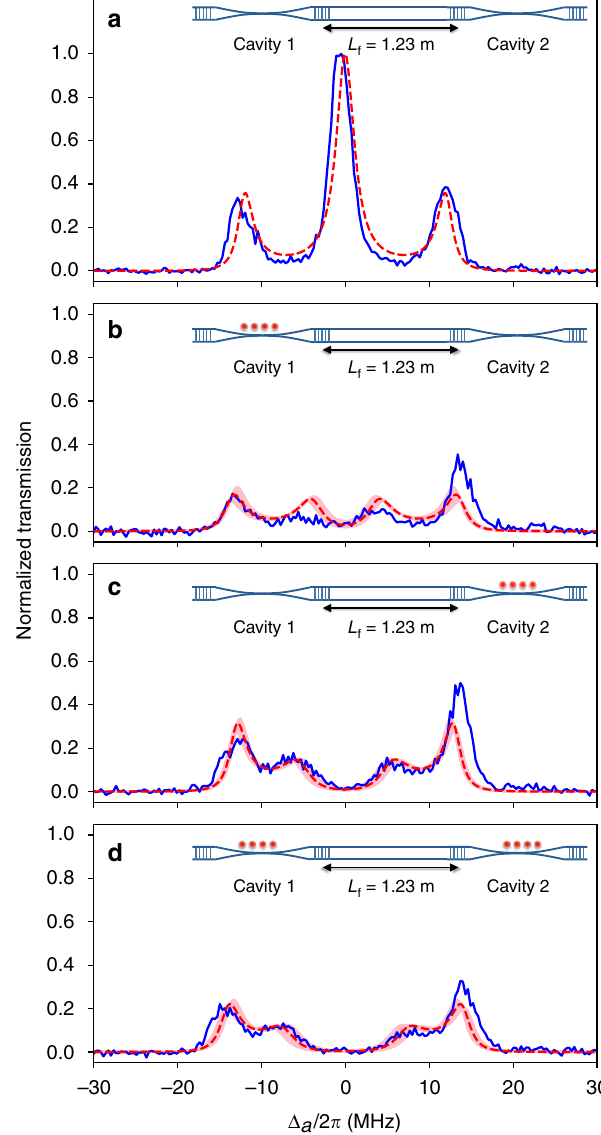
Fig. 2 Transmission spectra with different atom-loading conditions. a No atoms are loaded. b Atoms are loaded in cavity 1 only. c Atoms are loaded in cavity 2 only. d Atoms are loaded in both cavities. Blue solid lines represent experimental data, while red dashed lines and pink shaded bands are theoretical curves for ( g 1,eff , g 2,eff ) = 2 π × (7.2, 7.3) MHz and ( g 1,eff , g 2,eff ) = 2 π × (7.2 ± 1.0, 7.3 ± 1.0) MHz, respectively. When no atoms are loaded ( a ), formation of normal modes for three coupled empty cavities results in the clear triplet spectrum. The central peak corresponds to the fi ber-dark mode d , while the two side peaks correspond to the other two normal modes c ± . When atoms are loaded in one of the two ( b , c ), or both cavities ( d ), coupling between atoms and the fi ber-dark mode results in the splitting of the central peak observed in ( a ). In particular, the splitting observed in ( d ) is the signature of the dressed states of distant atoms